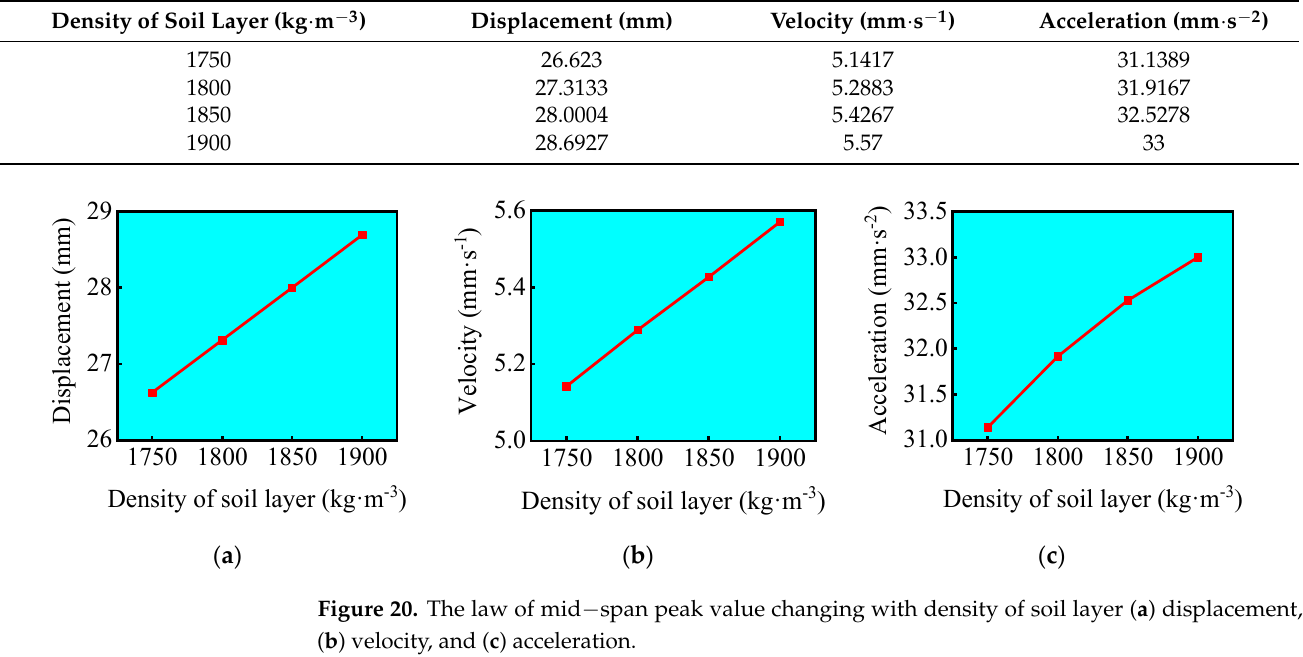
Figure 19. Peak value variation rule of different measuring points when the density of soil layer changes ( a ) displacement, ( b ) velocity, and ( c ) acceleration.